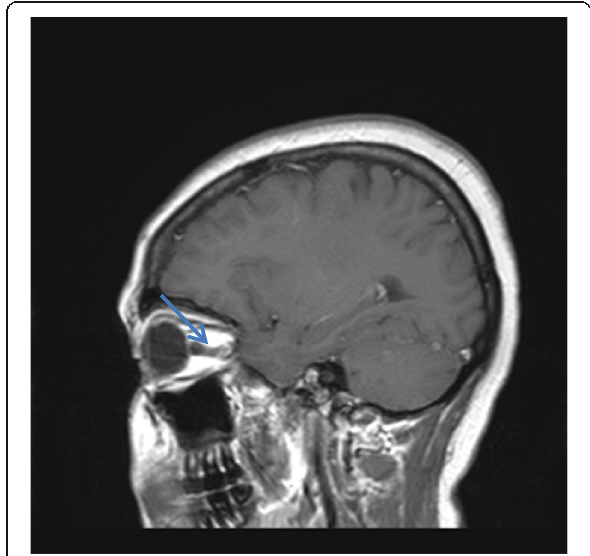
Fig. 5 MRI brain T1 sequence of 28-years-old lady showing vertical tortuosity of optic